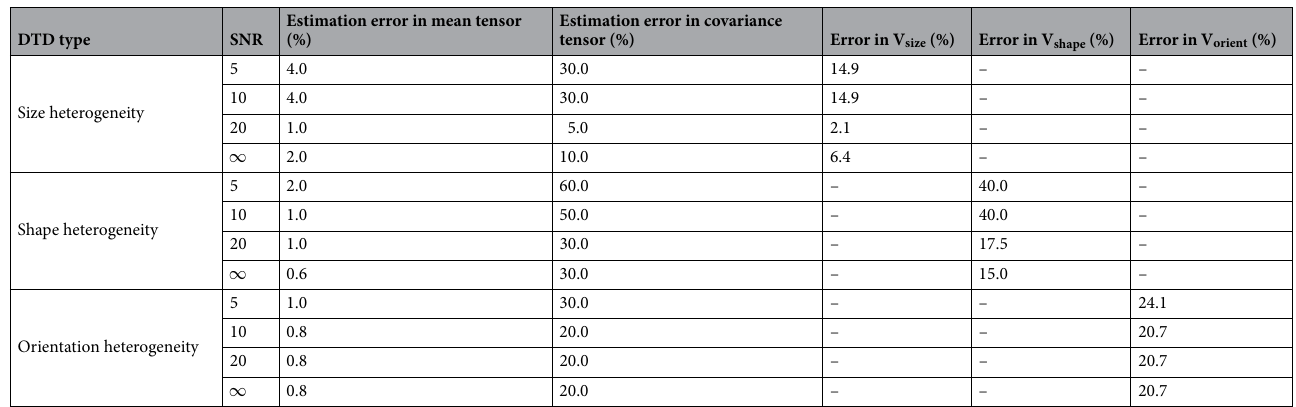
Table 1. Performance of the estimation pipeline and heterogeneity stains evaluated using different signal- to-noise ratio (SNR) for three different DTDs. Size heterogeneity refers to isotropic emulsion type DTD, shape heterogeneity refers to shape heterogeneous DTD with isotropic mean diffusion tensor and orientation heterogeneity refers to the DTD with two fibers crossing at 90 ◦ . The estimation error in mean and covariance tensors are calculated using the Frobenius norm of the difference between the actual and estimated tensors divided that of the actual tensor and expressed as percentage. The error in stains (i.e. V size , V shape , and V orient ) were expressed as percent change from the ground truth